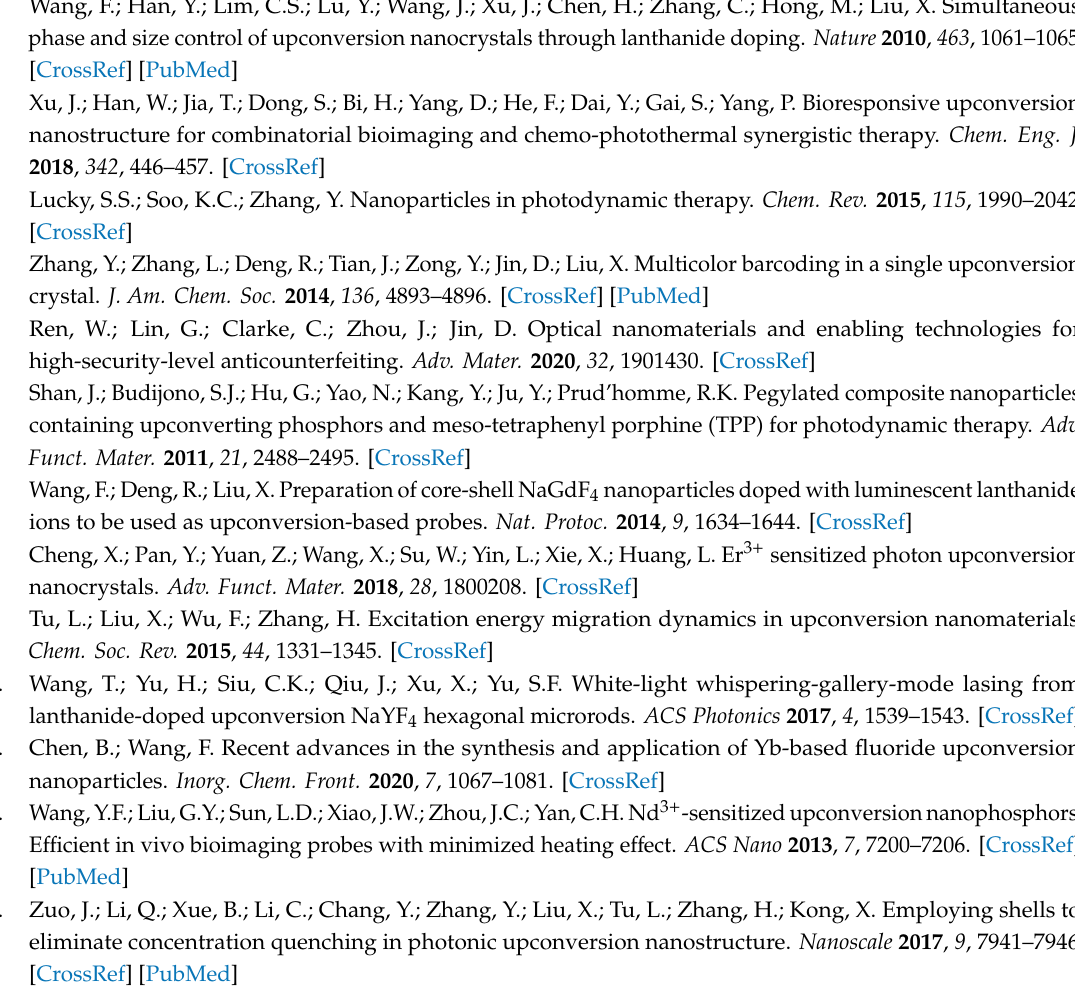
Figure S1: The synthesized Y 2 O 3 :Er 3 + / Tm 3 + UCNPs, Figure S2: The EDS spectra of the synthesized Y 2 O 3 nanoparticles doped with 8 mol% Er 3 + ions, Figure S3: The absolute luminescence spectra of the Y 2 O 3 :Er 3 + UCNPs doped with di ff erent concentration of Er 3 + ions. The inset shows the tendency of the integral luminescence intensities (from 500 to 700 nm). All excitation wavelengths are at 980 nm, Figure S4: UC emission intensities of Y 2 O 3 :Er 3 + / Tm 3 + (8 / x mol%) UCNPs as a function of excitation intensities. (a) x = 0, (b) x = 1. All excitation wavelengths are at 808 nm, Figure S5: Normalized UC emission spectra of Y 2 O 3 : Er 3 + / Tm 3 + (8 / x mol%) UCNPs under the excitation of lasers operated at di ff erent pulse width. (a) x = 0, 980 nm excitation, (b) x = 1, 980 nm excitation, (c) x = 0, 808 nm excitation, (d) x = 1, 808 nm excitation, Figure S6: Cuboid fresh pork with the size of 6 cm × 2 cm × 2 cm, Table S1: The experimental elemental composition of the Y 2 O 3 :Er 3 + (8 mol%)